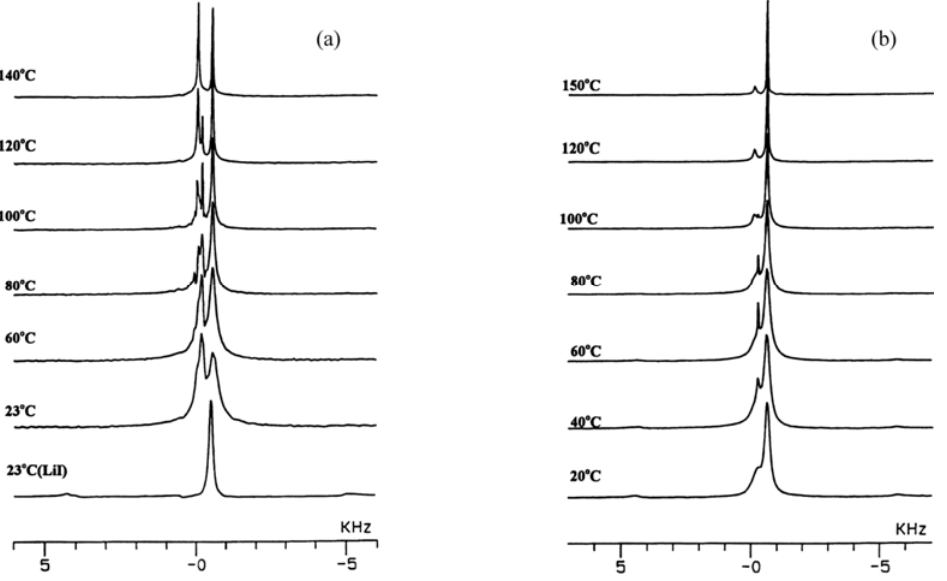
Figure 2. Comparison between variable-temperature 7 Li MAS NMR spectra of LiI/Al 2 O 3 samples: ( a ) 50/50, bottom spectrum is pure LiI reference compound; ( b )